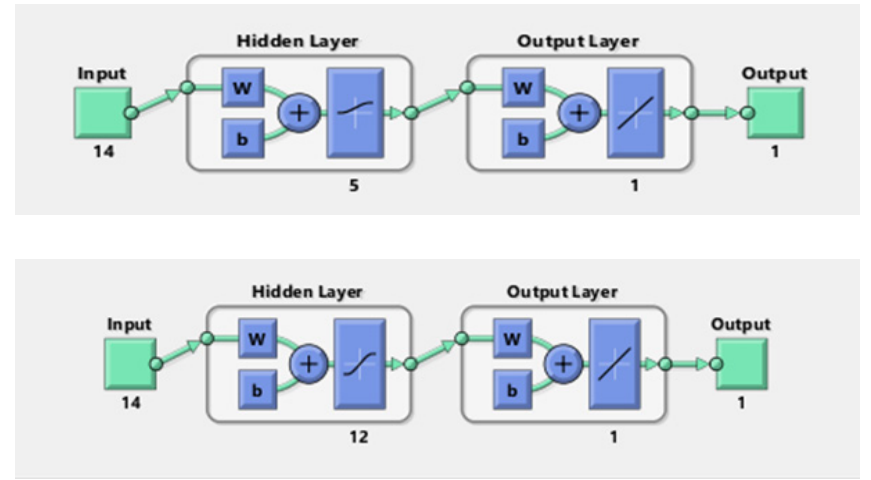
Figure 9. Architectures of models M5 (above) and M10 (below). Source: Authors’ elaboration.